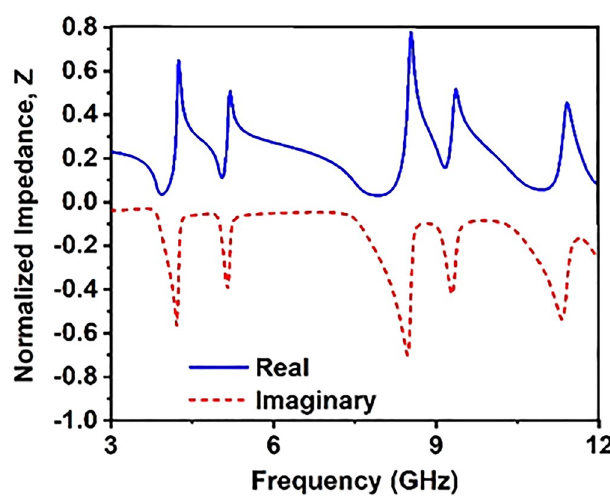
Figure 11. Impedance curve of the structure